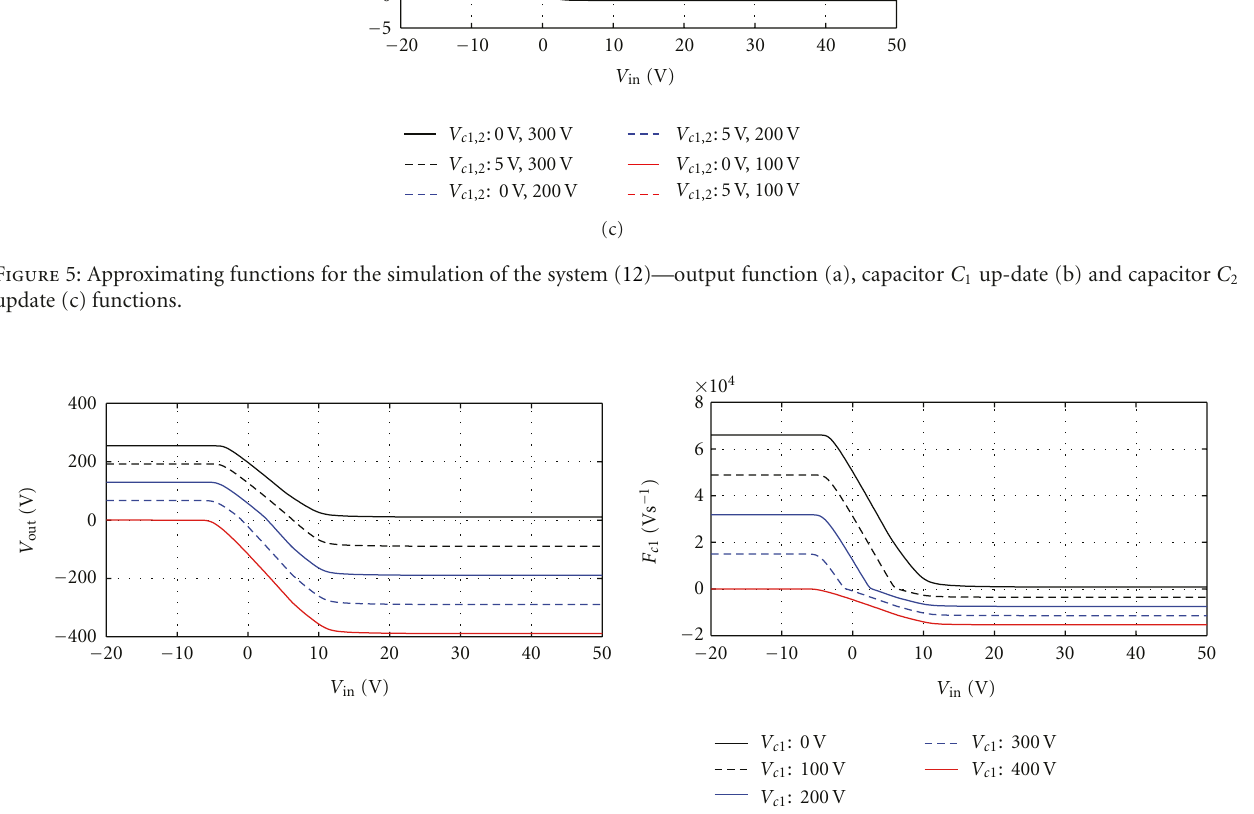
the algorithms were tested with an E-chord guitar ri ff with maximal amplitude around 200 mV. The whole circuit simulation required 2.79 iterations on average and 100 iterations at the most. In the case of the simulation using block decomposition, the average numbers of iterations were i 1 = 2 . 1294, i 2 = 2 . 4149, i 3 = 2 . 6806 and maximal numbers of iterations were i 1 = 4, i 2 = 5, i 3 = 100 for each block, respectively. The number of iteration of individual block di ff ers because each block processes a di ff erent signal. The maximum number of iteration was 100 and the error limit of